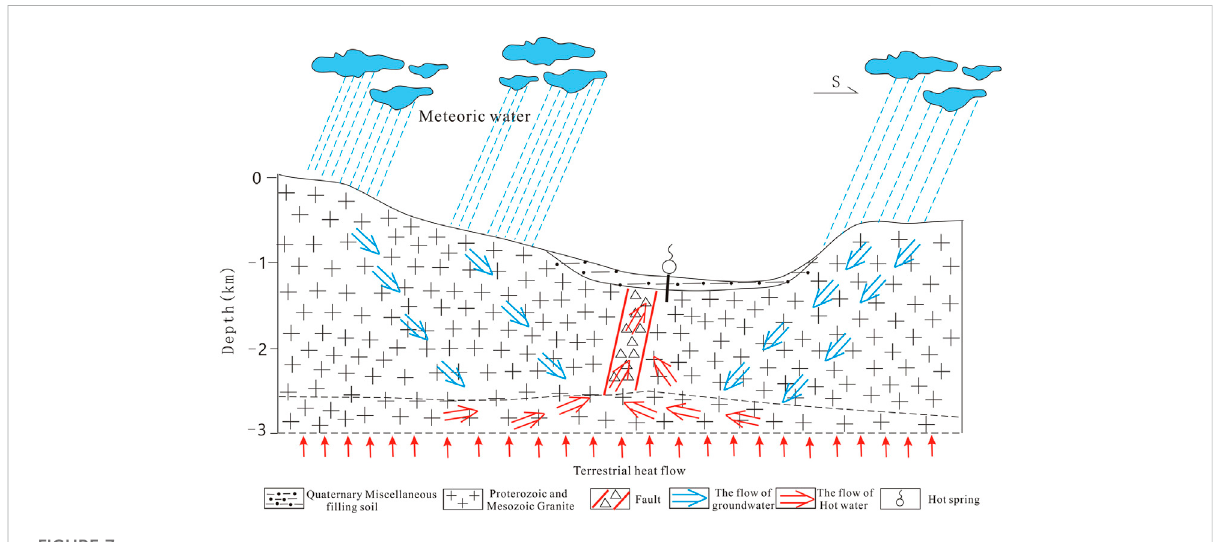
FIGURE 7 Genesis model of the Hongshuilantang Hot Spring.